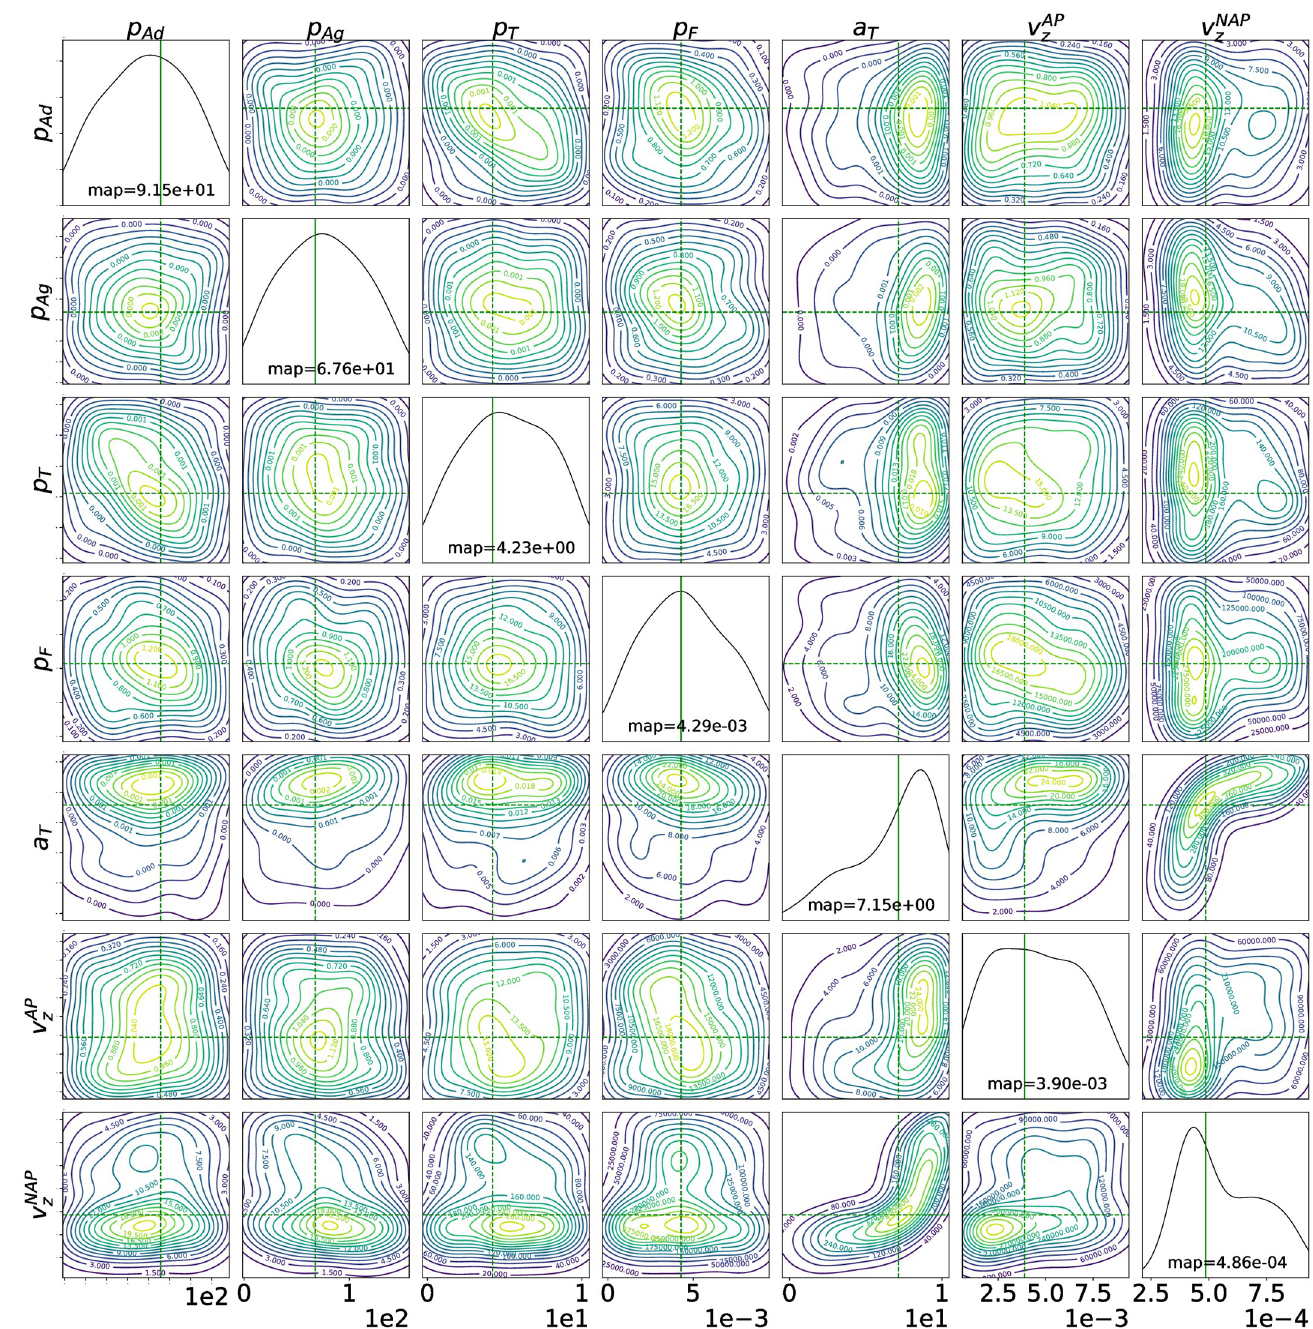
Fig 1. Posterior distribution of the model parameters for a COPD patient. The green cross indicates the maximum a posteriori (MAP) estimate of the parameters p [ s − 1 ], p [ s − 1 ], p [ s − 1 ], p [ s − 1 ], a [ μm 2 s − 1 ], v AP ½ ms (cid:0) 1 � , v NAP ½ ms (cid:0) 1 � Ad Ag T F T z z